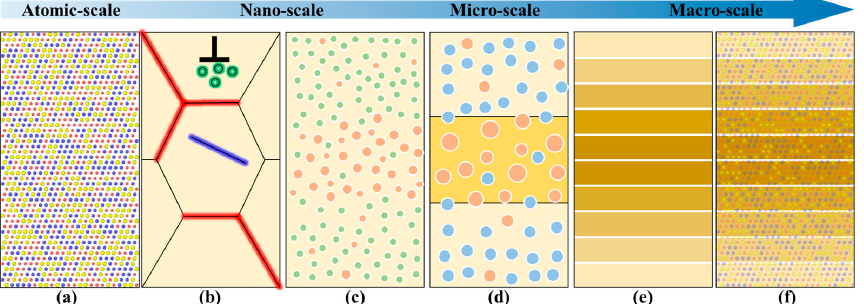
Figure 1. Schematic diagram illustrating different types of chemical inhomogeneity, including ( a ) chemical short-range order, ( b ) segregation of different structures (green, red and blue represent segregation via dislocation, grain boundary and stacking faults, respectively), ( c ) compositional fluctuations, ( d ) compositional fluctuations with phase transition, ( e ) compositional gradient, and ( f ) a combination of compositional gradient and CSRO.